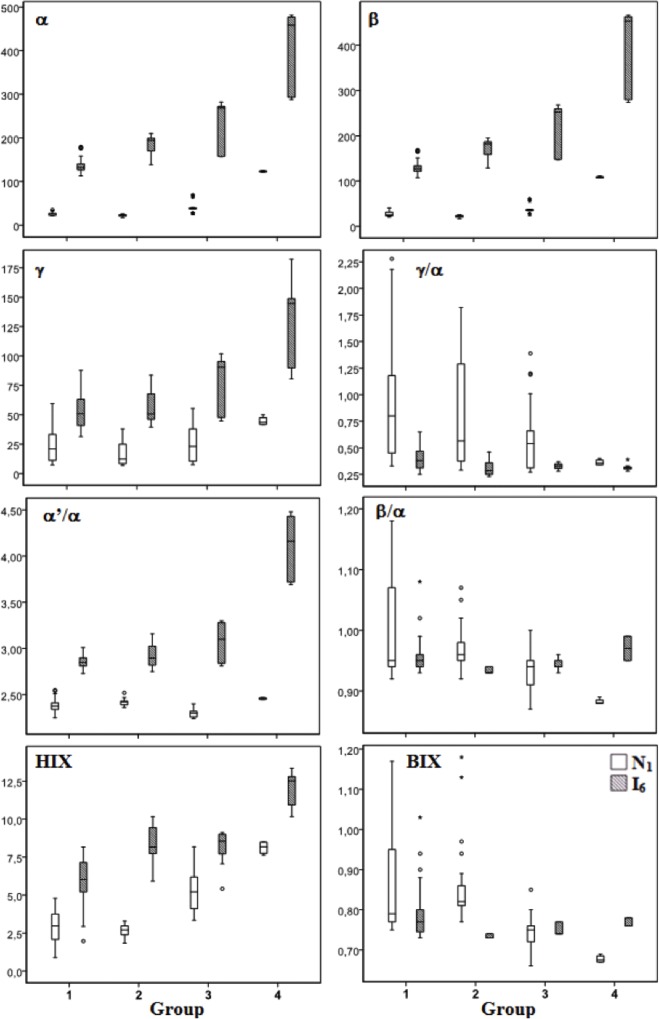
Boxplots of the intensities (in QSU) of several fluorophores (α, β and γ), of ratios between those intensities (γ/α, α’/α and β/α) and of fluorescence indexes BIX and HIX within the different groups of samples at the marine (station N1) and brackish water (station I6) zones of the estuary Ria de Aveiro.